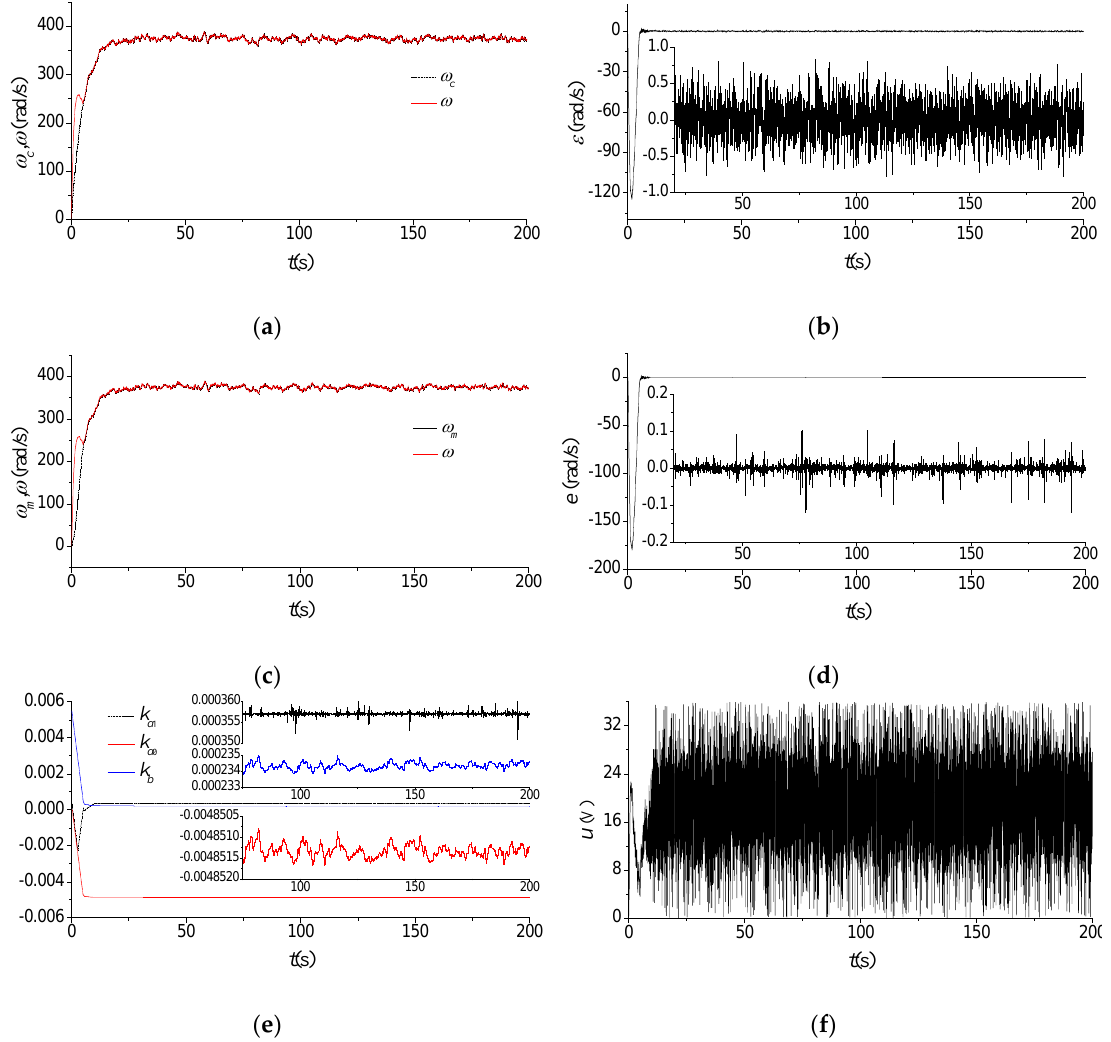
ω and ω ; ( b ) ε ; ( c ) c